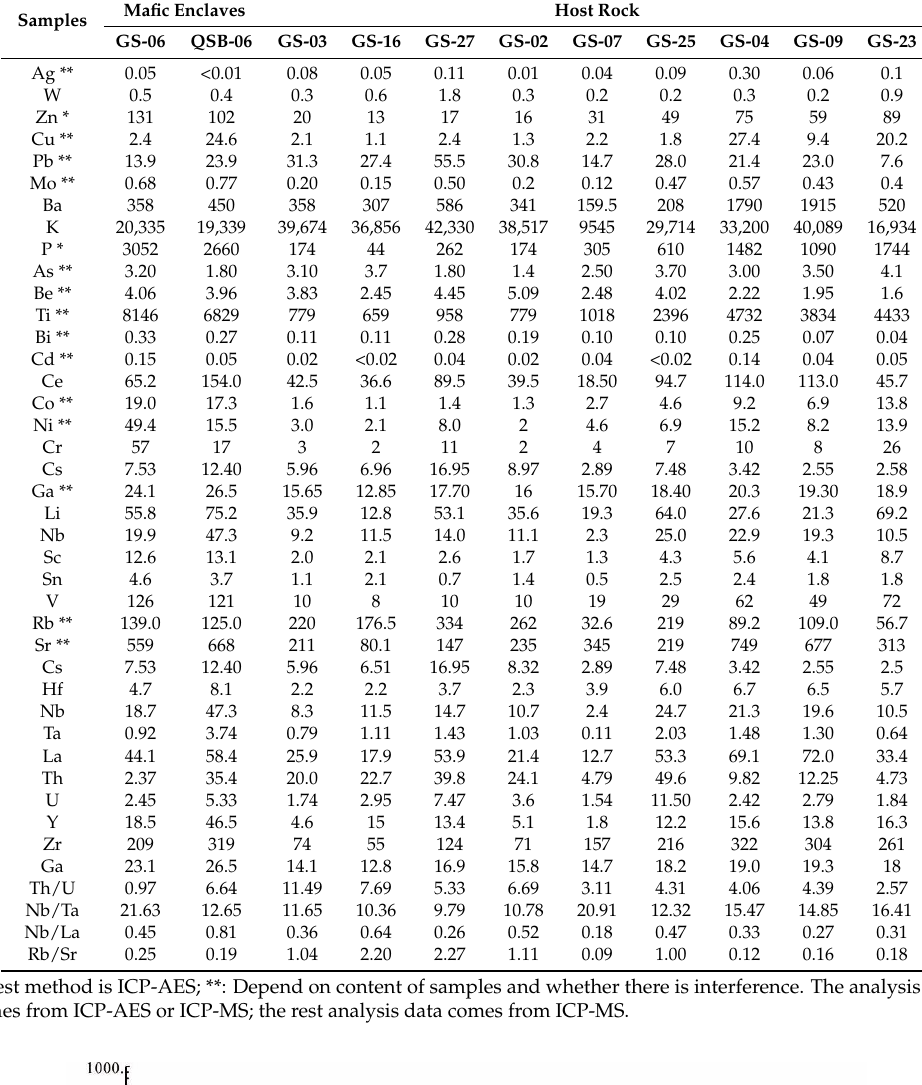
Table 4. Trace element content of the mafic enclaves and the Qingshanbao host rock (wt/10 − 6 ). Samples